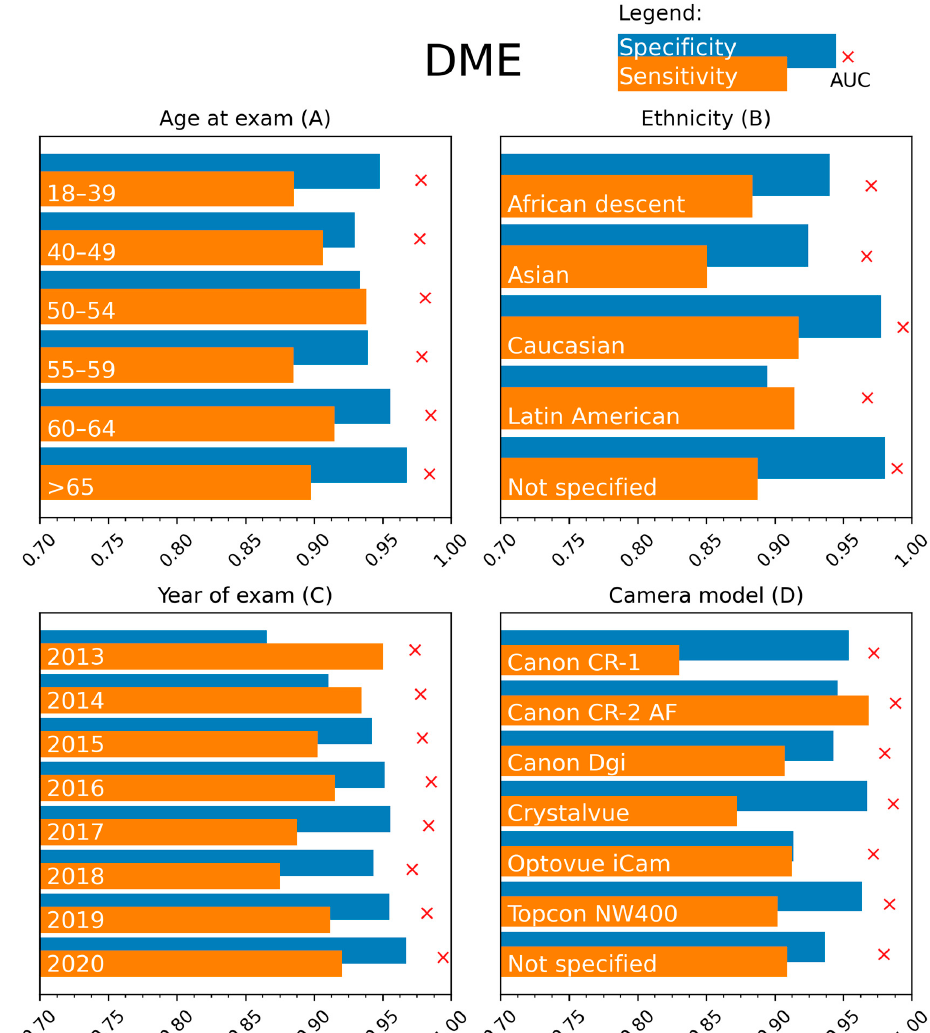
Figure 2. Stratification results: sensitivity (orange), specificity (blue), and AUC (red cross) for detecting referable DR for different subgroups of the test set. The subgroups were created based on presented metadata, namely age at the exam (in years), ethnicity, year of exam, and camera model.